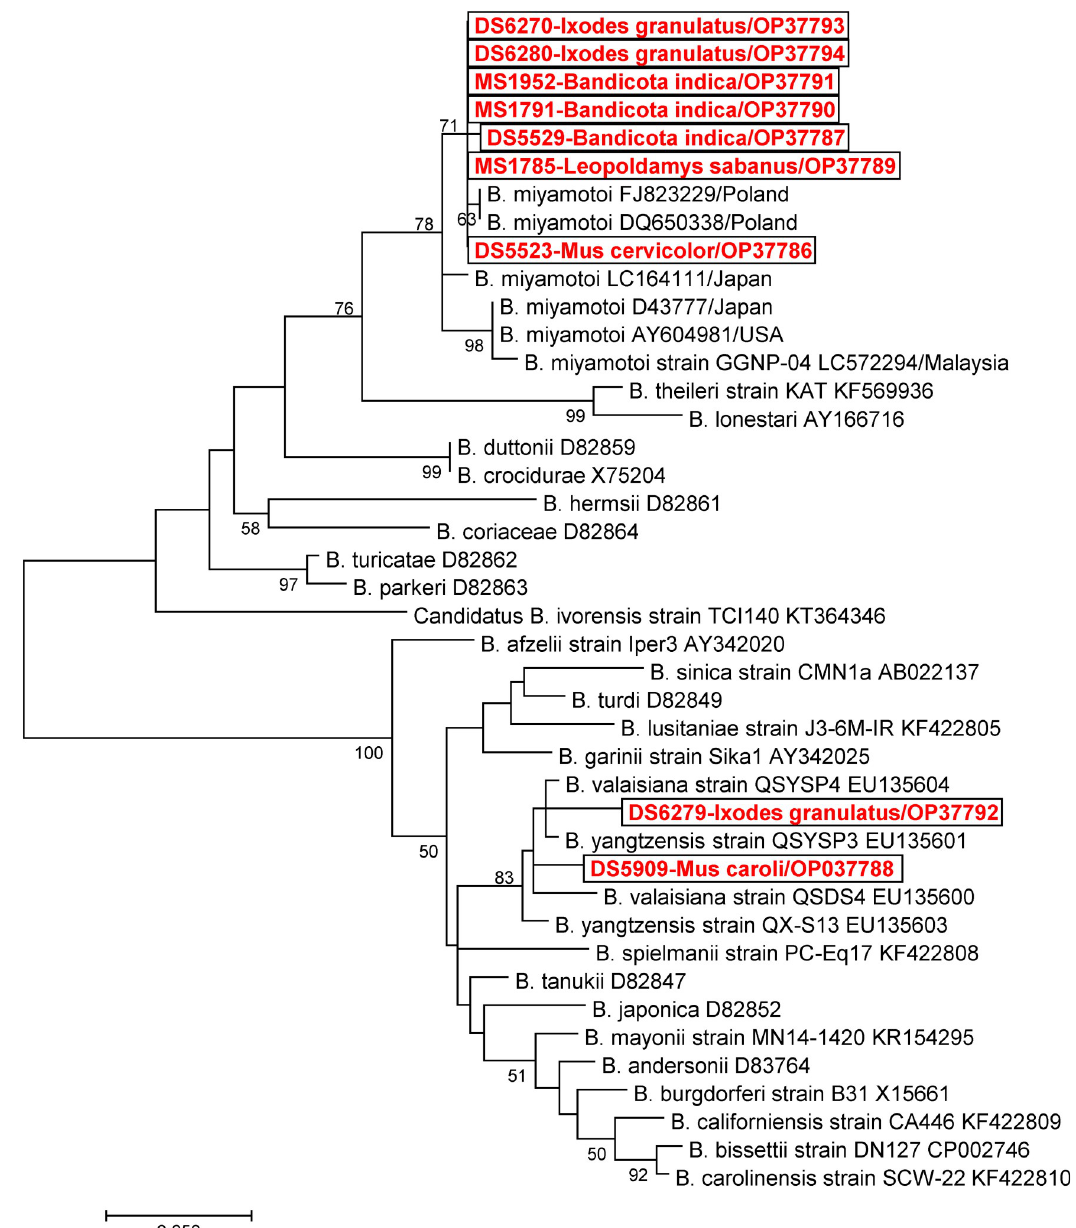
Fig 2. Phylogenetic trees of 16S rRNA gene of Borrelia species detected in rodents and their associated ticks in Phop Phra district, Tak province, Thailand (2019–2020). Two pools of I . granulatus females collected from M . caroli and B . bowersi were positive for B . miyamotoi (2/27, 7.4%). Three tick pools (two pools of Haemaphysalis spp. nymphs and one pool of I . granulatus females) each collected from R . tanezumi , M . caroli , and B . bowersi were positive for B . yangtzensis (3/27, 11.1%) (Table 1). One I . granulatus female collected from M . caroli was positive for B . theileri (1/27, 3.7%).